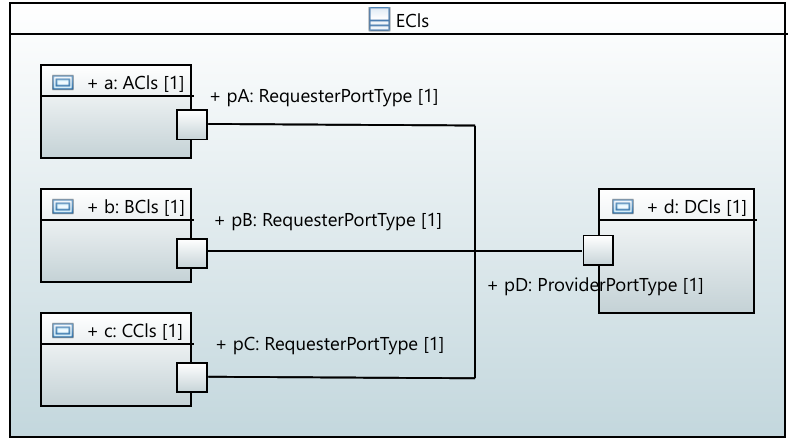
Figure 12. E1 level UML model composite structure diagram for the request barrier